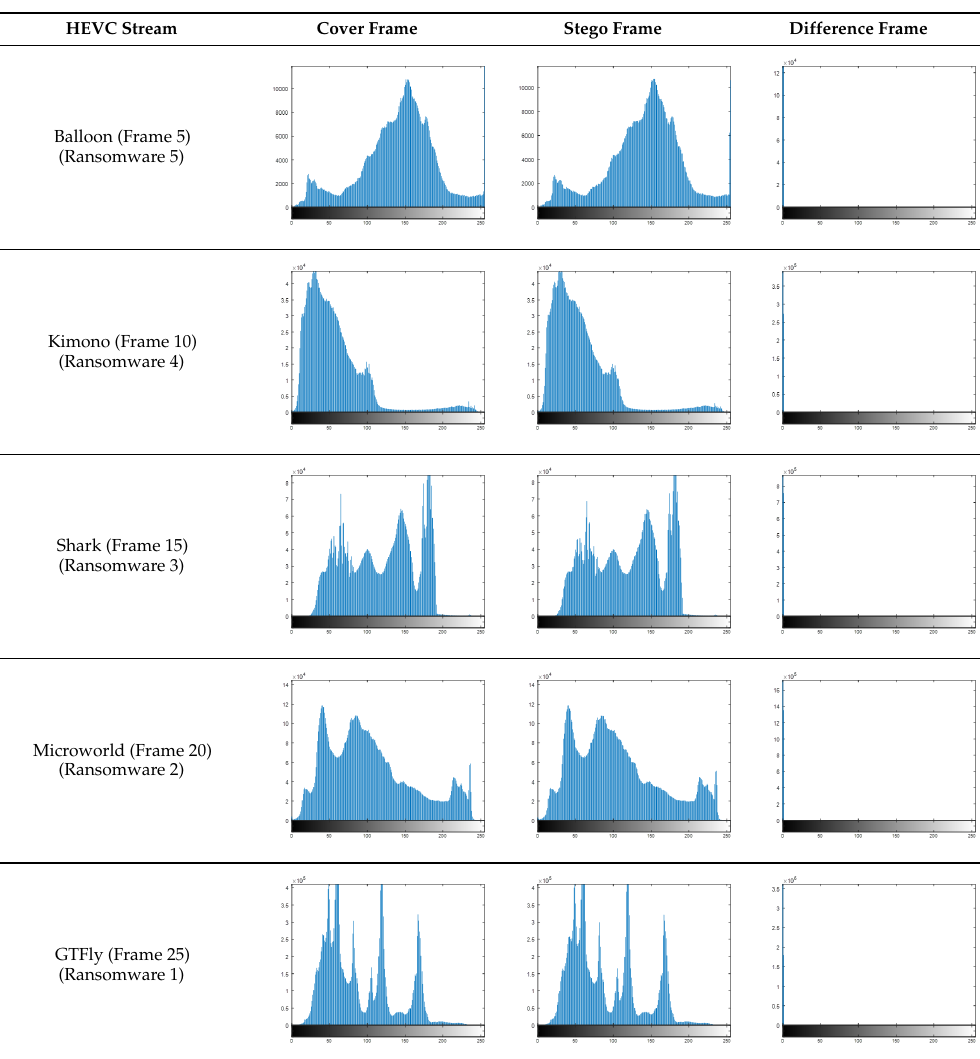
Table 5. Histogram outcomes of the tested HEVC frames in case of using different ransomware